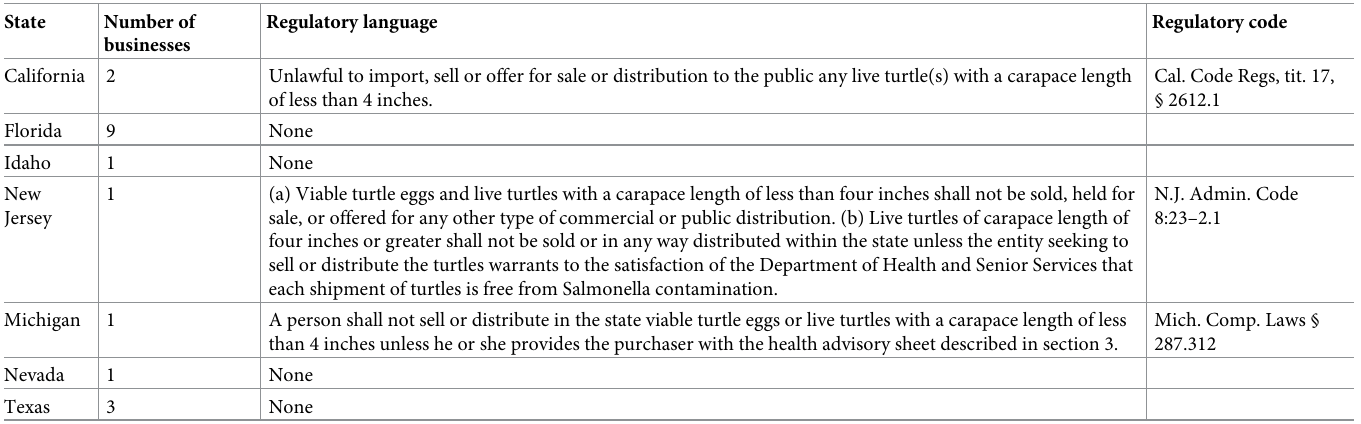
Table 1. States in which headquarters or operations centers are located for 16 websites selling turtles < 4 inches in size and state regulations applicable to these sales [9]. One business operated from three states (CA, ID, TX); all others operated from one